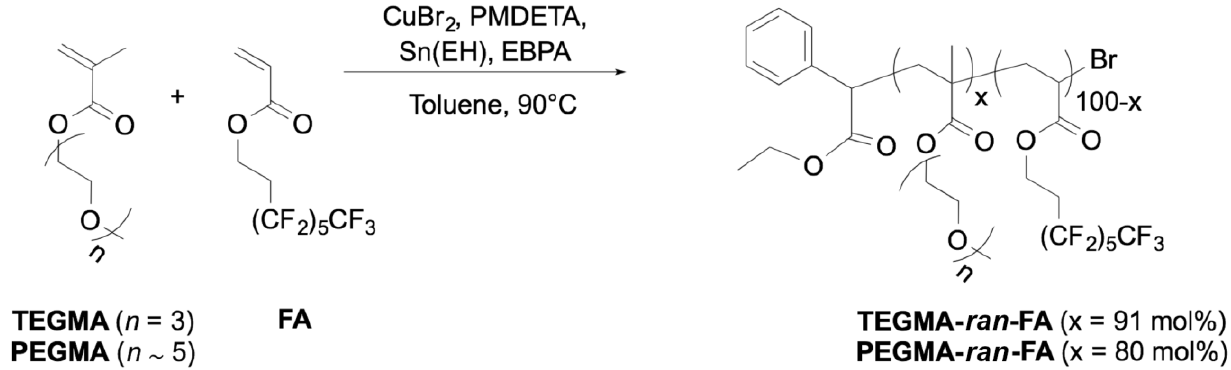
Figure 2. Schematic of the synthesis of the amphiphilic random copolymers via ARGET-ATRP.